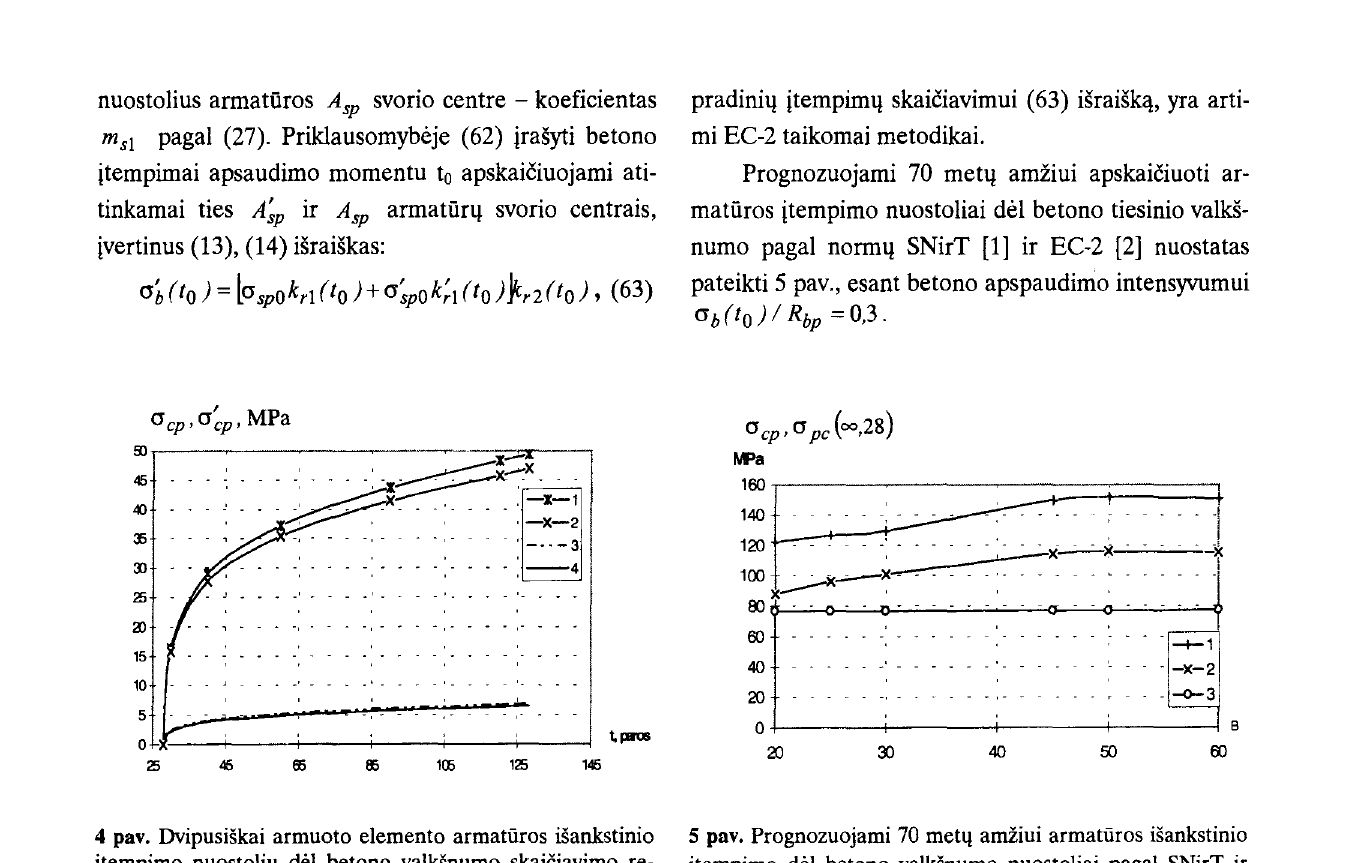
Fig 4. Calculation results of steel prestress losses due to concrete creep in doubly reinforced prestressed member: 1 - losses in the bottom steel according to the relationship (33) of proposed method, 2 - the same according to modified relationship of EC-2 (62) and (64), 3- losses in the upper steel according to relationship (34) of proposed method, 4- the same according to modified relationship (62) of EC-2 and (63)